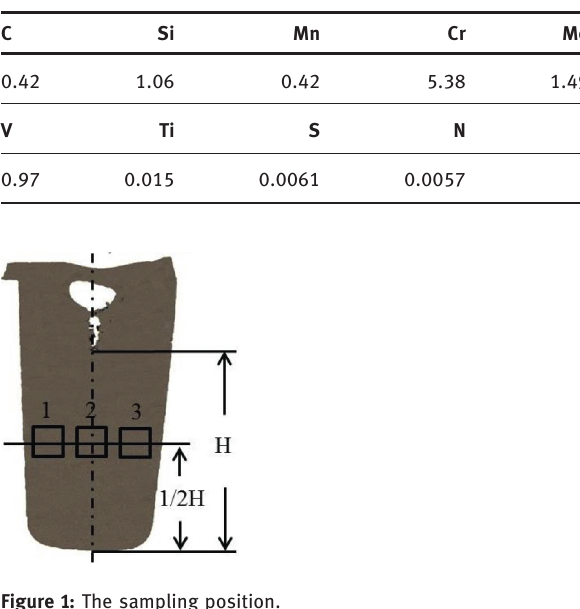
Table 1: The composition of ingot, wt%.